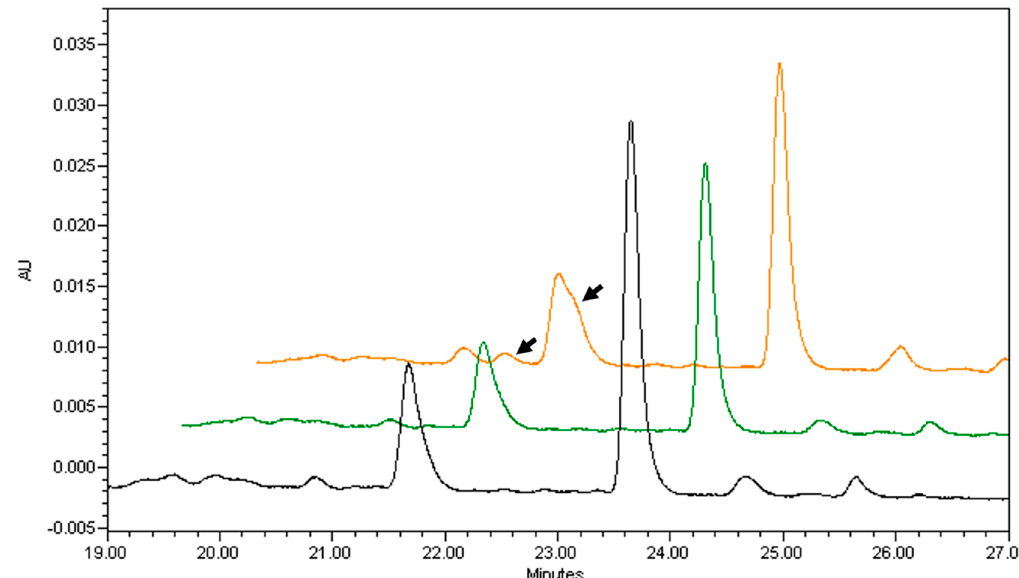
Figure 2. Purity and isomer variation between three commercial sources of β -carotene. HPLC chromatograms detected at 452 nm were obtained using YMC C30 column in three different commercially available β -carotene sources. The largest peak shows all-trans- β -carotene. Smaller peaks correspond to different carotenoid isomers (probably cis forms) in each commercial source. Arrows show the presence of two peaks only present in the orange chromatogram (probably β -carotene cis forms). AU, arbitrary units.